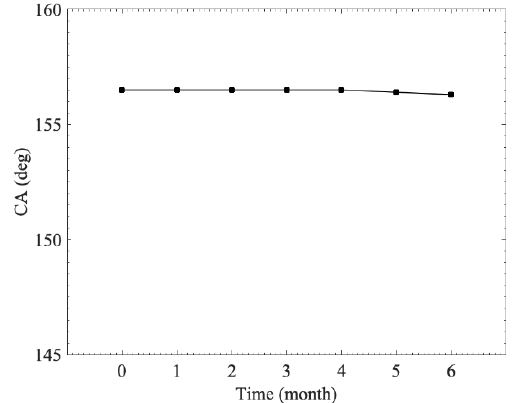
Figure 14. Stability of the superhydrophobic surface.